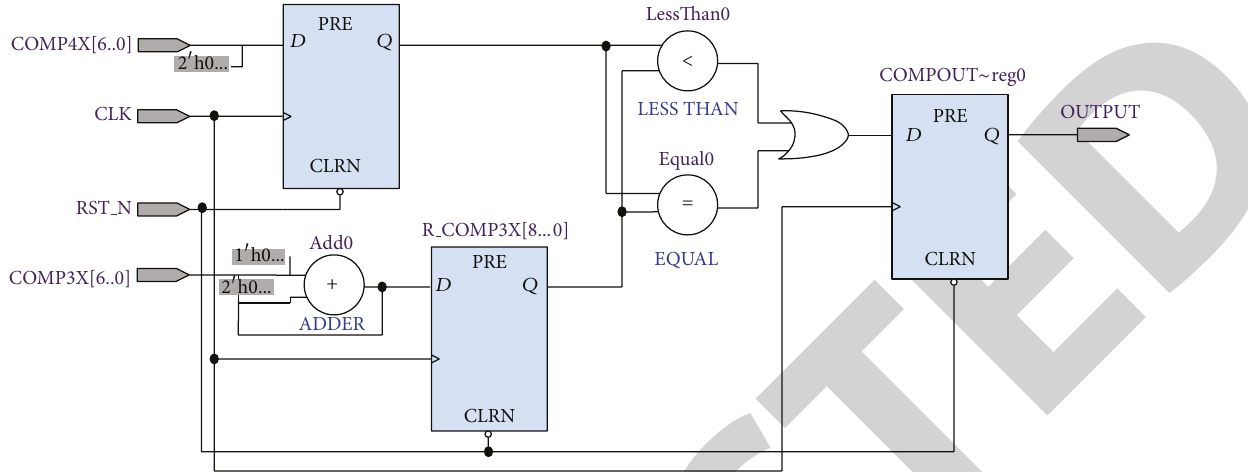
Figure 5: The RTL schematic of comparison module in the unique matching